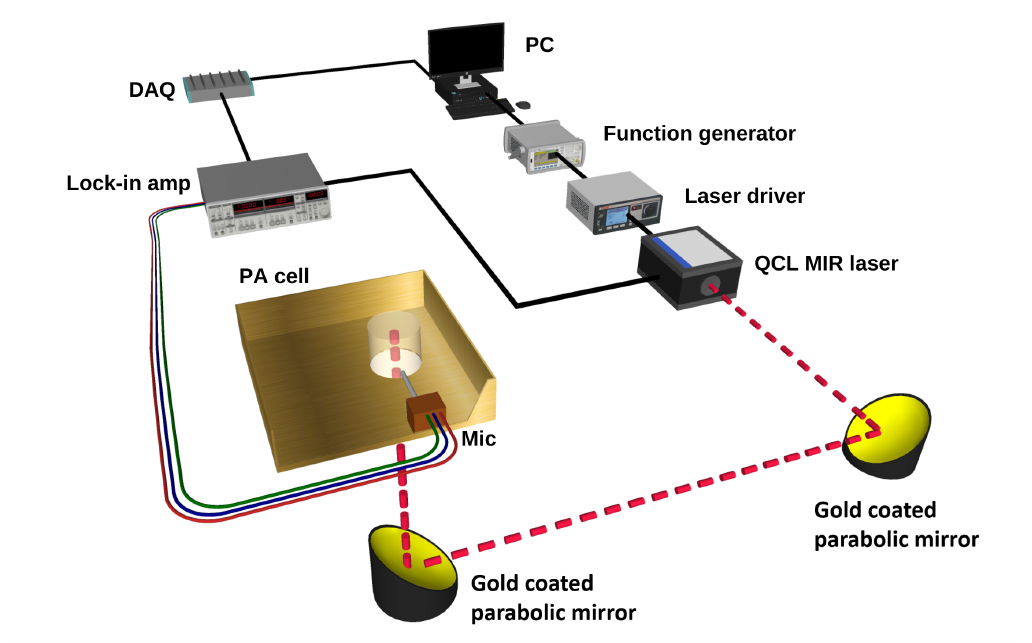
Figure 2. Schematic of the setup used for glucose detection using MIR and PA